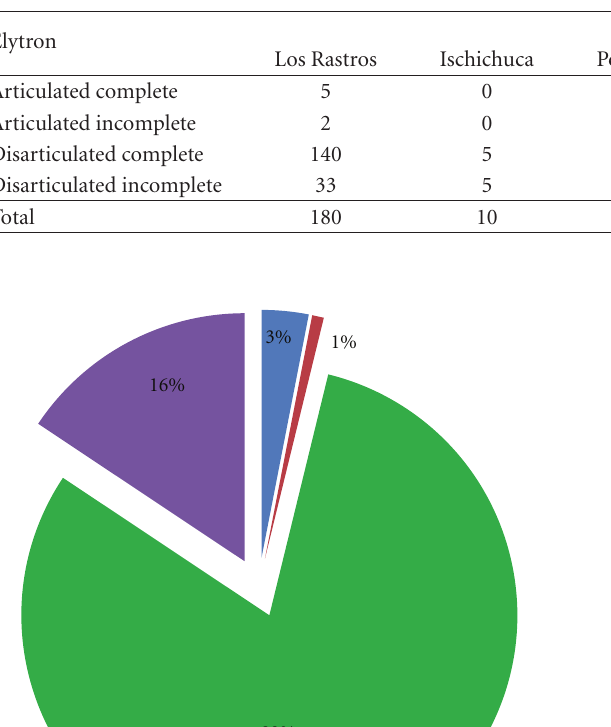
Table 2: State of preservation of the Triassic beetles.